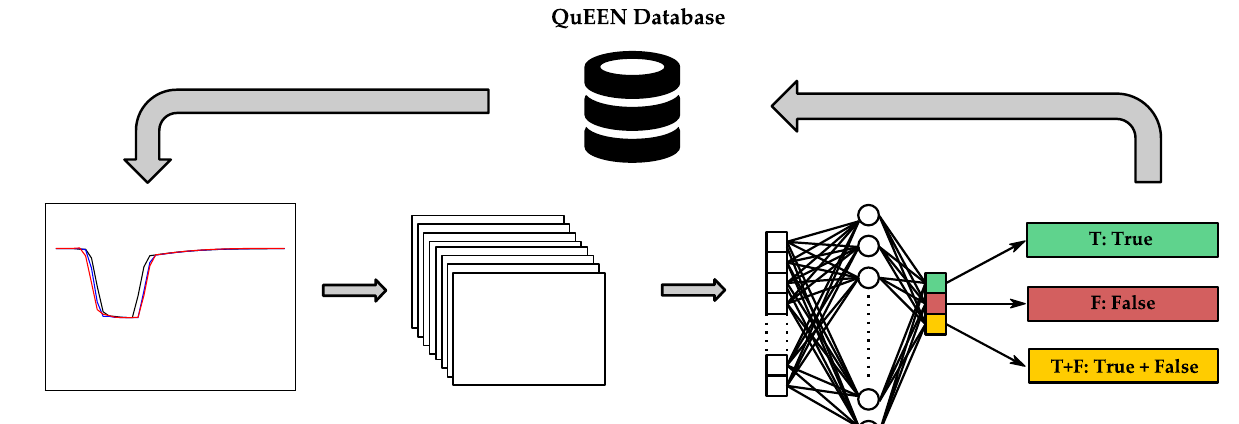
Figure 8. DELFI architecture. Table 2. DELFI Classifier—CNN